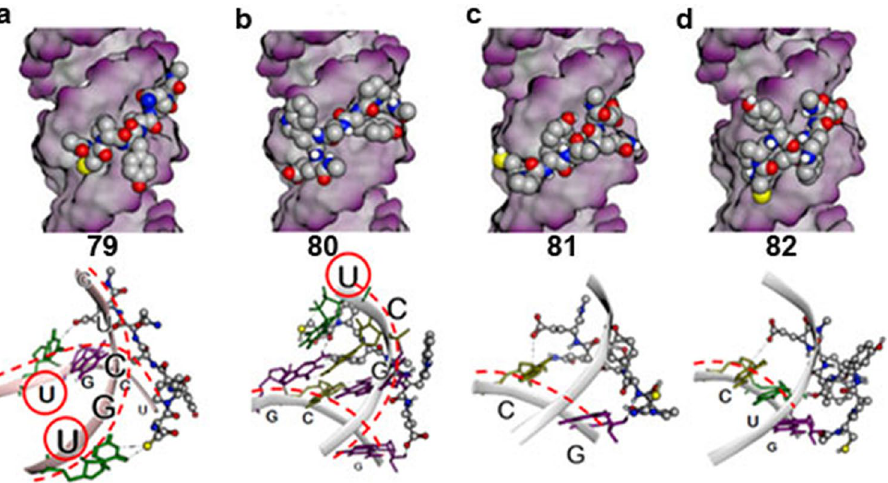
Figure 7. Modeling of the proposed interaction between the candidate peptides and the CUG RNA. Representation of the results obtained by means of a flexible docking directed to the area of the RNA exposed to the solvent. Two different binding mechanisms are proposed: peptides 79 ( a ) and 80 ( b ) might interact with the double-stranded RNA (red lines), recognizing the indicated uracils (red circles); peptides 81 ( c ) and 82 ( d ) might interact with one-stranded RNA (red line). Molecular representations included were generated using MOE 2019.01 software (Chemical Computing Group, https:// www. chemc omp.